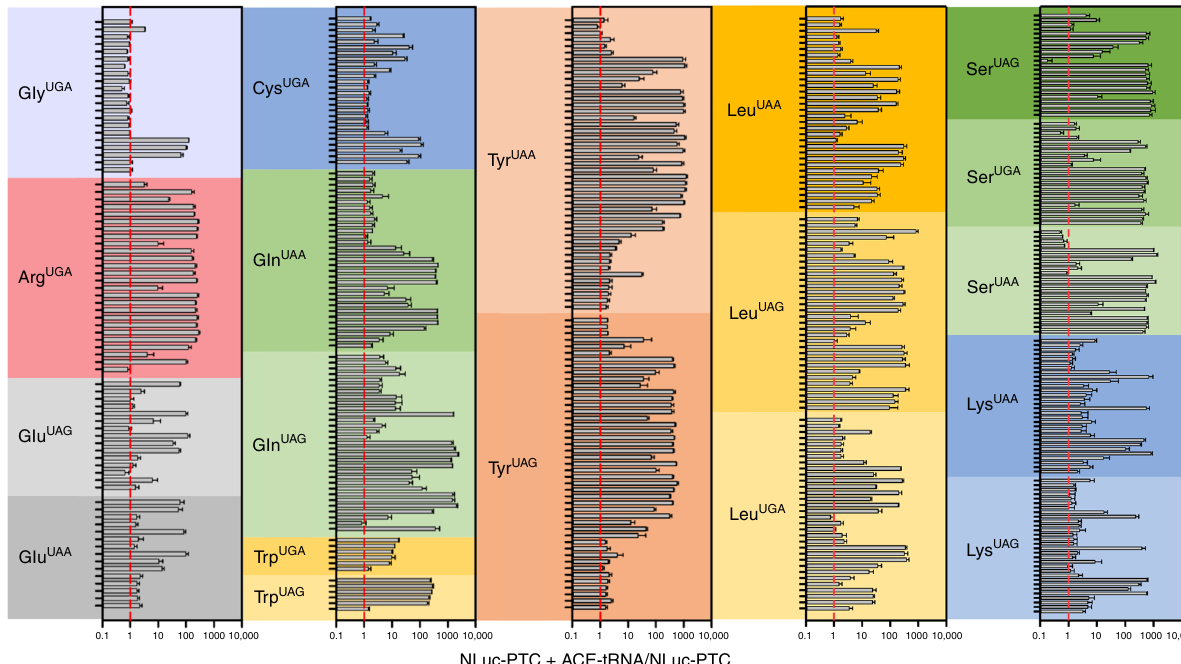
Fig. 2 Screens of ACE-tRNA gene families with the high throughput cloning nonsense mutation reporter platform. The indicated anticodon edited PTC sequences were tested for each ACE-tRNA family that is one nucleotide away from the endogenous anticodon sequence, Supplementary Figure 1. Multiple high performing suppressor tRNA were identi fi ed for each class. Data are shown in Log10 scale in terms of normalized NLuc luminescence. Each tRNA dataset were obtained in triplicates and are displayed at average ± SEM. Coded identities and corresponding tRNA sequences are shown in Supplementary Figure 2a and Supplementary Data 1, respectively. Predicted cloverleaf structures for ACE-tRNAs for each family are included in Supplementary Figure 2b. The numerical values and ANOVA statistical analysis are located in Supplementary Data 2, where the order of tRNAs are maintained in top to bottom list